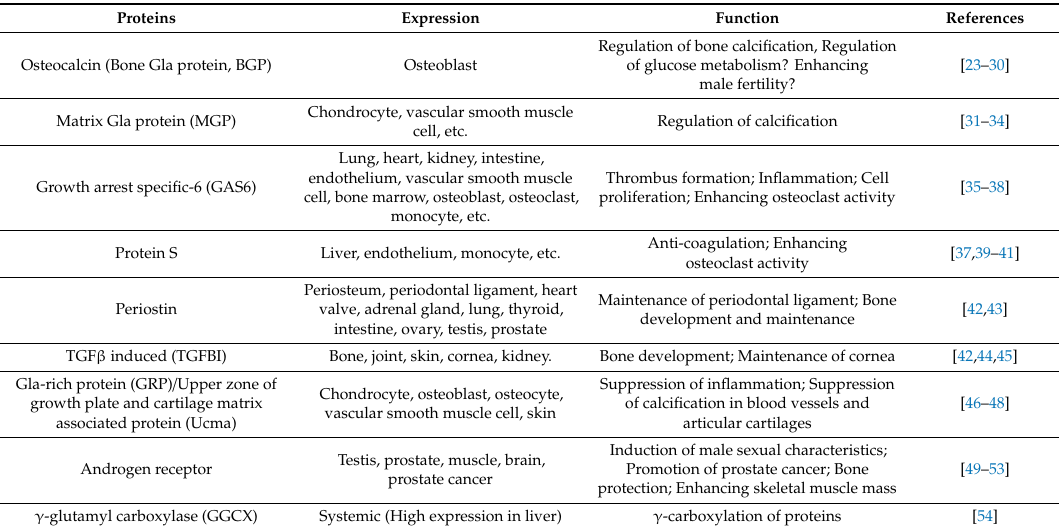
Table 1. Musculoskeletal disease-related γ -carboxylated proteins. Among 20 kinds of proteins known to be γ -carboxylated, 9 proteins are related or possibly related to musculoskeletal diseases.